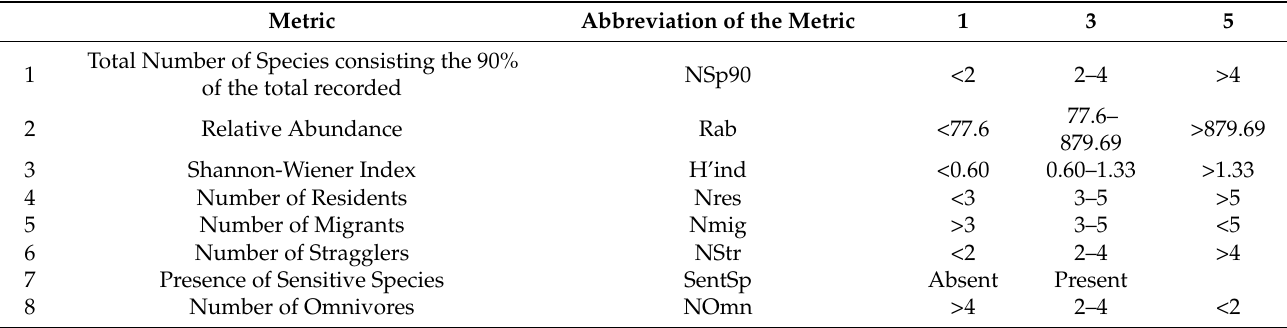
Table 3. The thresholds obtained for each metric consisting of the multimetric index for the assessment of the water quality of Greek lagoons (LFI), using the interquartile range and taking into consideration the deviation of each “reference value” from the median, and the maximum and minimum quartiles.